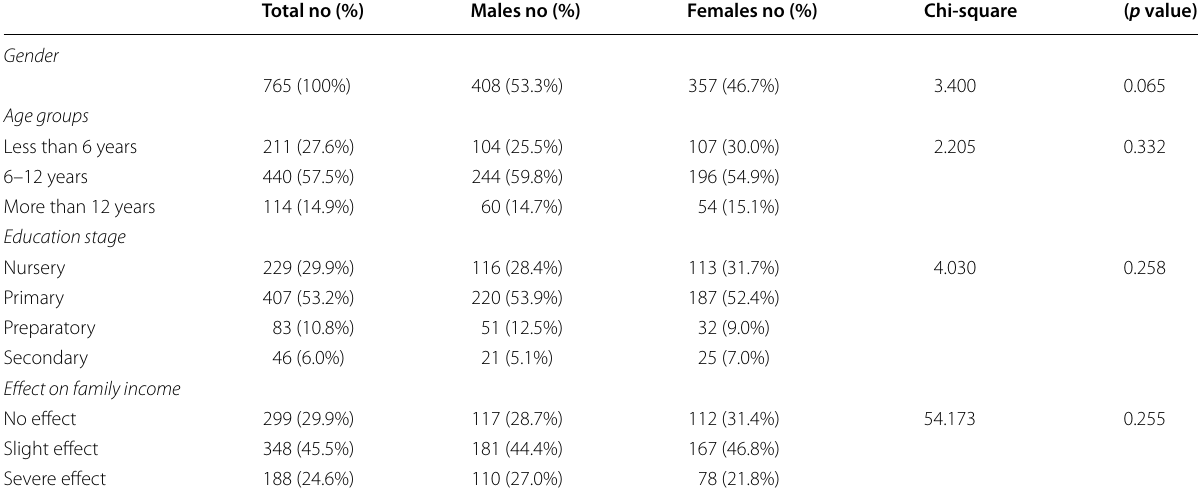
P : Sig. (2-tailed), *significant at the 0.05 level, **highly significant at the 0.005